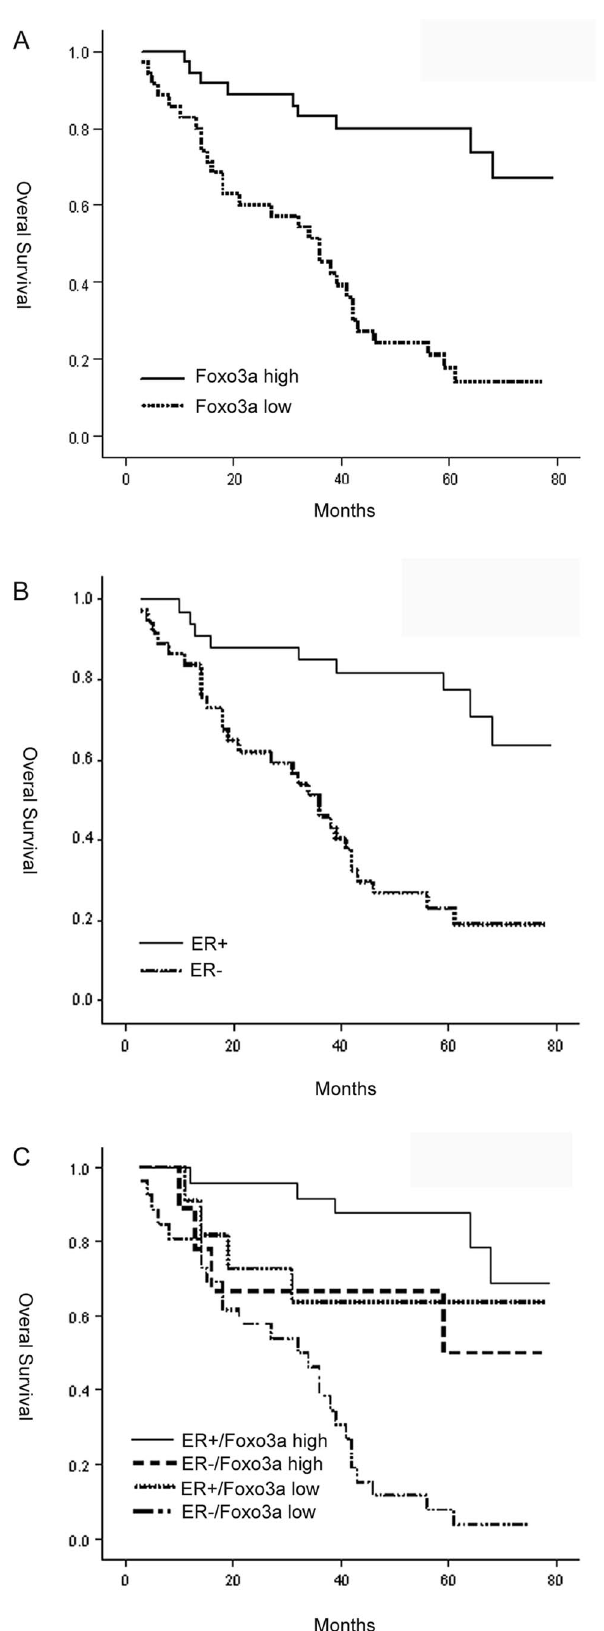
Figure 5. Kaplan–Meier analysis of breast cancer patients. The effect of Foxo3a (A) or ER (B) expression on overall survival in 70 patients with breast carcinoma. Kaplan-Meier curves showing the overall survival for subgroups of patients stratified by ER/Foxo3a staining